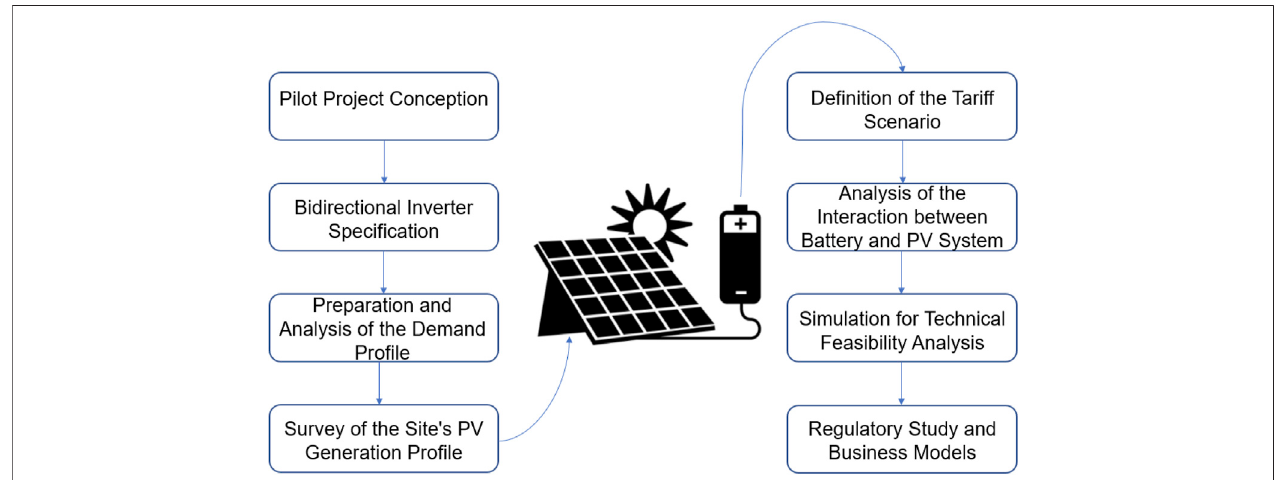
FIGURE 2 | Flowchart of the proposed